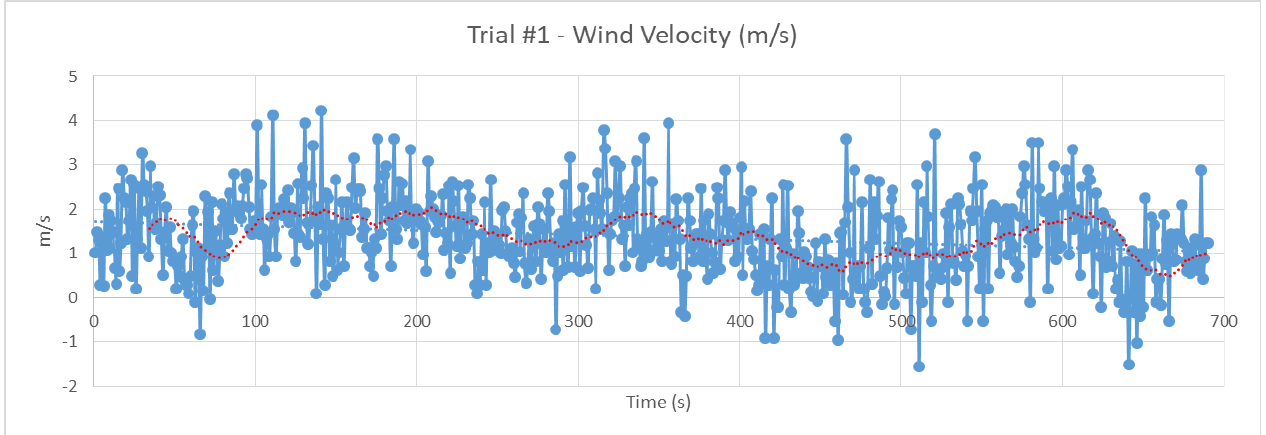
Figure 8. Trial #1 — Wind velocity. Figure 8. Trial #1—Wind